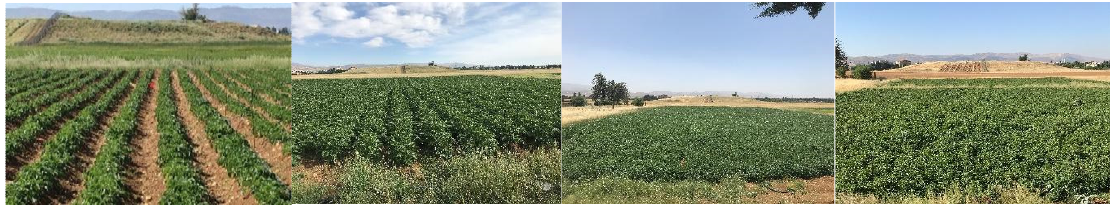
Figure 6. Images of potato growth stages in the field used to validate the app (from right to left: 6 May, 26 May, 9 June, and 29 June).